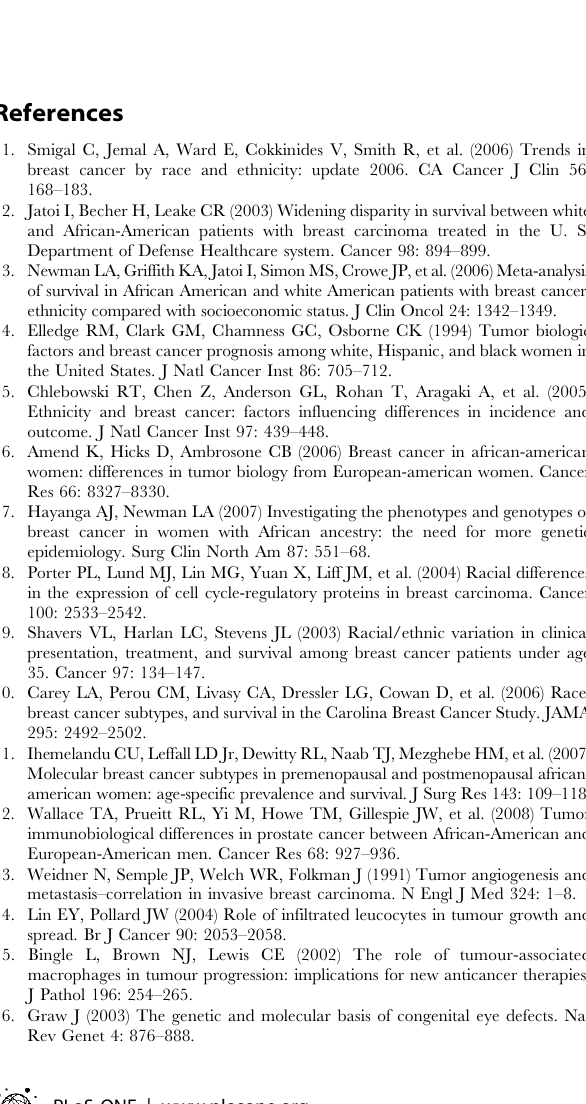
Found at: doi:10.1371/journal.pone.0004531.s003 (0.03 MB